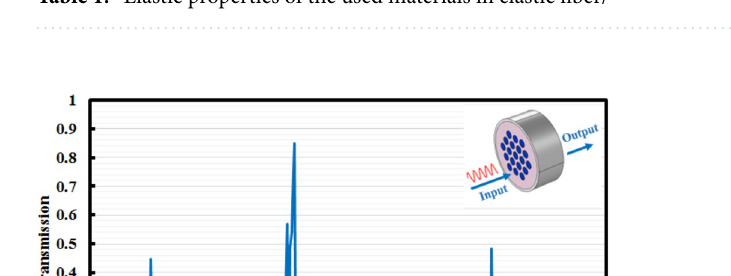
Table 1. Elastic properties of the used materials in elastic fiber/